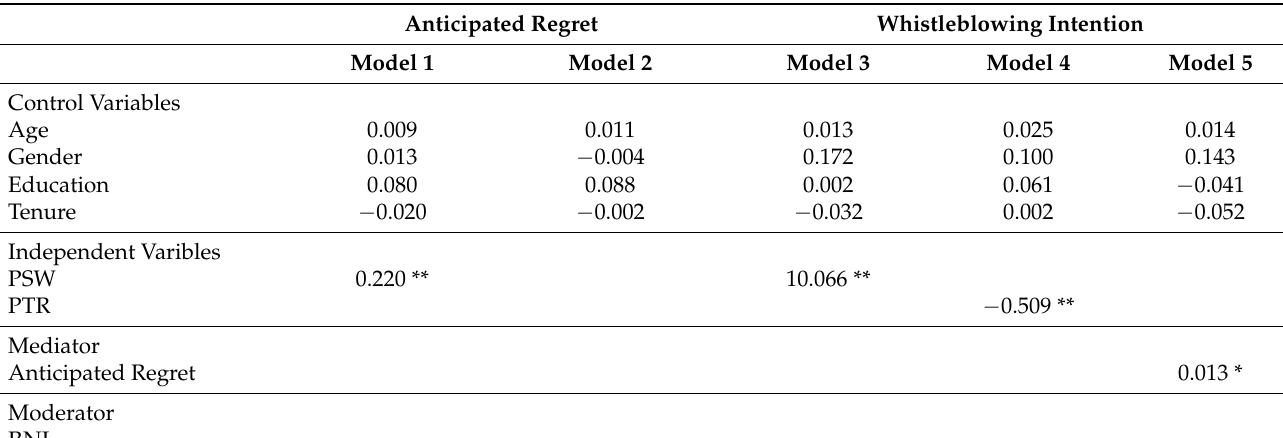
Table 4. Results of hierarchical regression analyses (N =